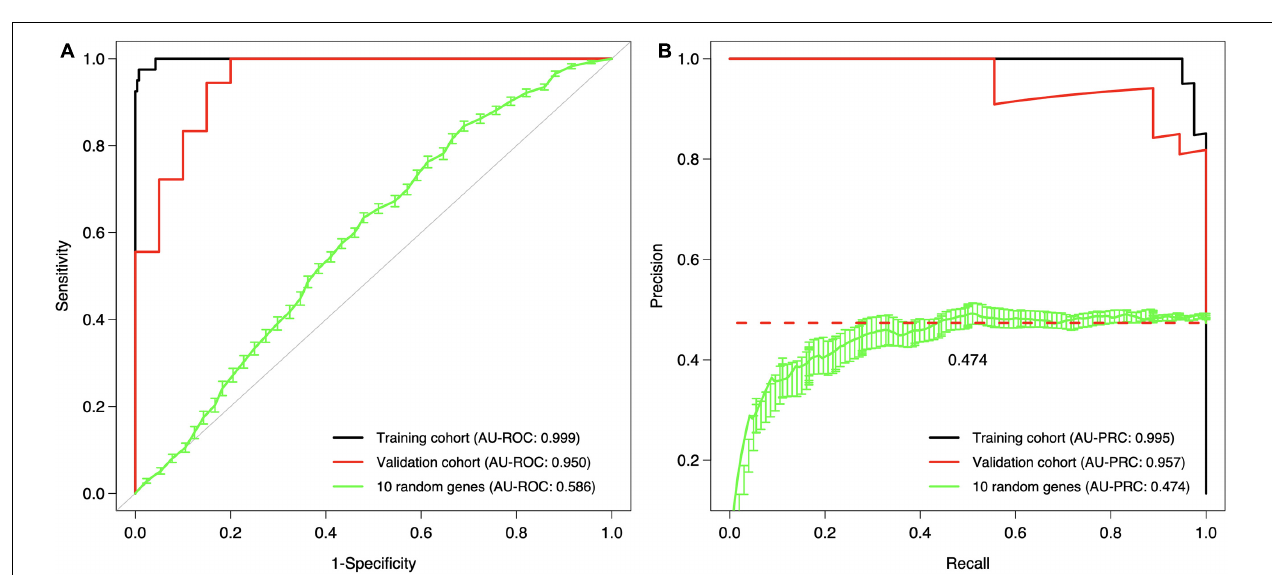
FIGURE 5 | Classification accuracy of the 10-gene signature against existing scores. (A) ROC, (B) PRC. Each signature was calculated based on the training patient cohort. The ROR score is based on the PAM50 genes (Parker et al., 2009), invasiveness score is based on 64 invasiveness related genes (Anastassiou et al., 2011), and DX R (cid:13) DCIS score based on seven genes (Solin et al., 2013). The expression values of the 64 genes were converted to z-score over each gene, and the average z-score was used as the invasiveness score for each sample. The original DX R (cid:13) DCIS score was based on qPCR data, but here it was applied to microarray gene expression data. The curves show the mean sensitivity and specificity over 10 CV folds in the training cohort. See Supplementary Table 5 for the SD of the AU-ROC and AU-PRC values.